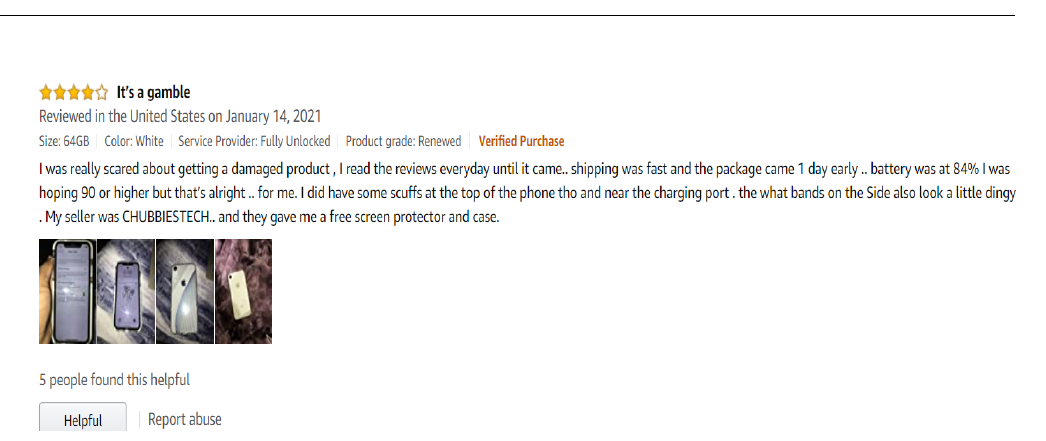
Figure A3. Amazon product review example for a renewed iPhone XR.